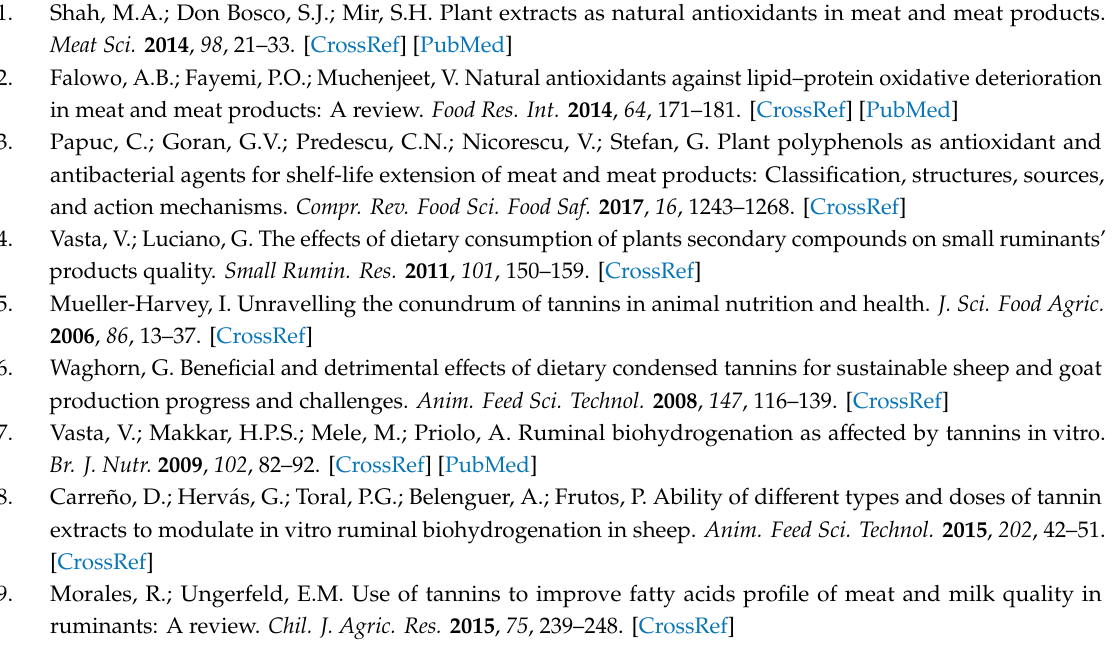
Table S1: E ff ect of the dietary treatment 1 on the main fatty acids (g / 100 of total FAME) of meat. Author Contributions: Conceptualization, L.B., C.L.R.; Data curation, N.R., A.P., K.V.H., A.N., C.C., C.L.R.; Formal analysis, N.R., K.V.H., A.N.; Methodology, N.R., A.P., A.N., K.V.H.; Supervision, L.B., C.L.R.; Writing—review